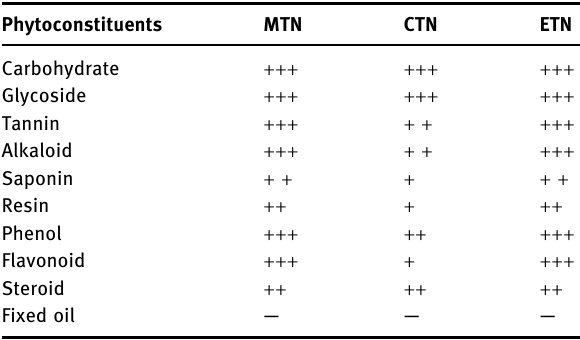
Table 1: Screening of bioactive phytoconstituents of T. nudi fl ora leaf extracts Phytoconstituents